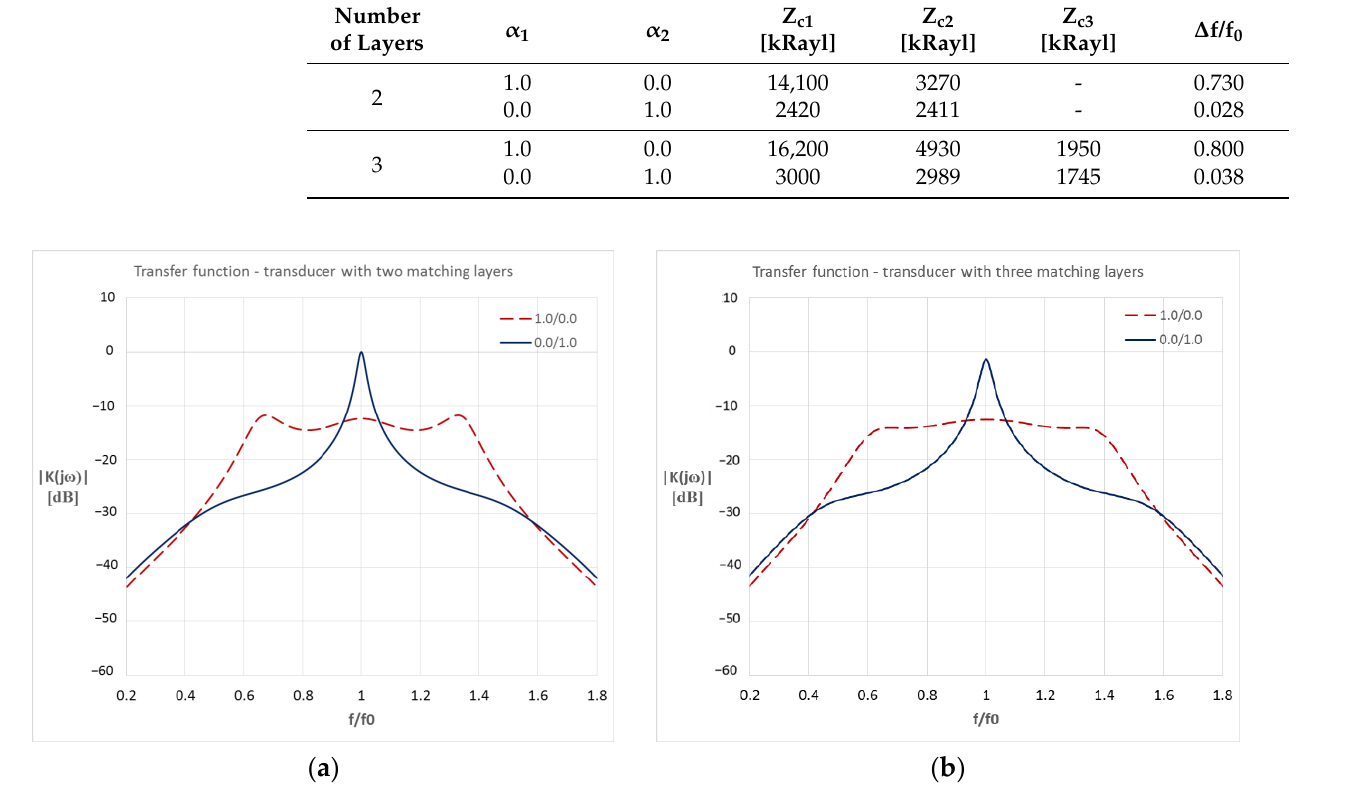
Figure 5. Analysis of the transfer function for the transducer operated in water: ( a ) with 2 matching layers, ( b ) with 3 matching layers.